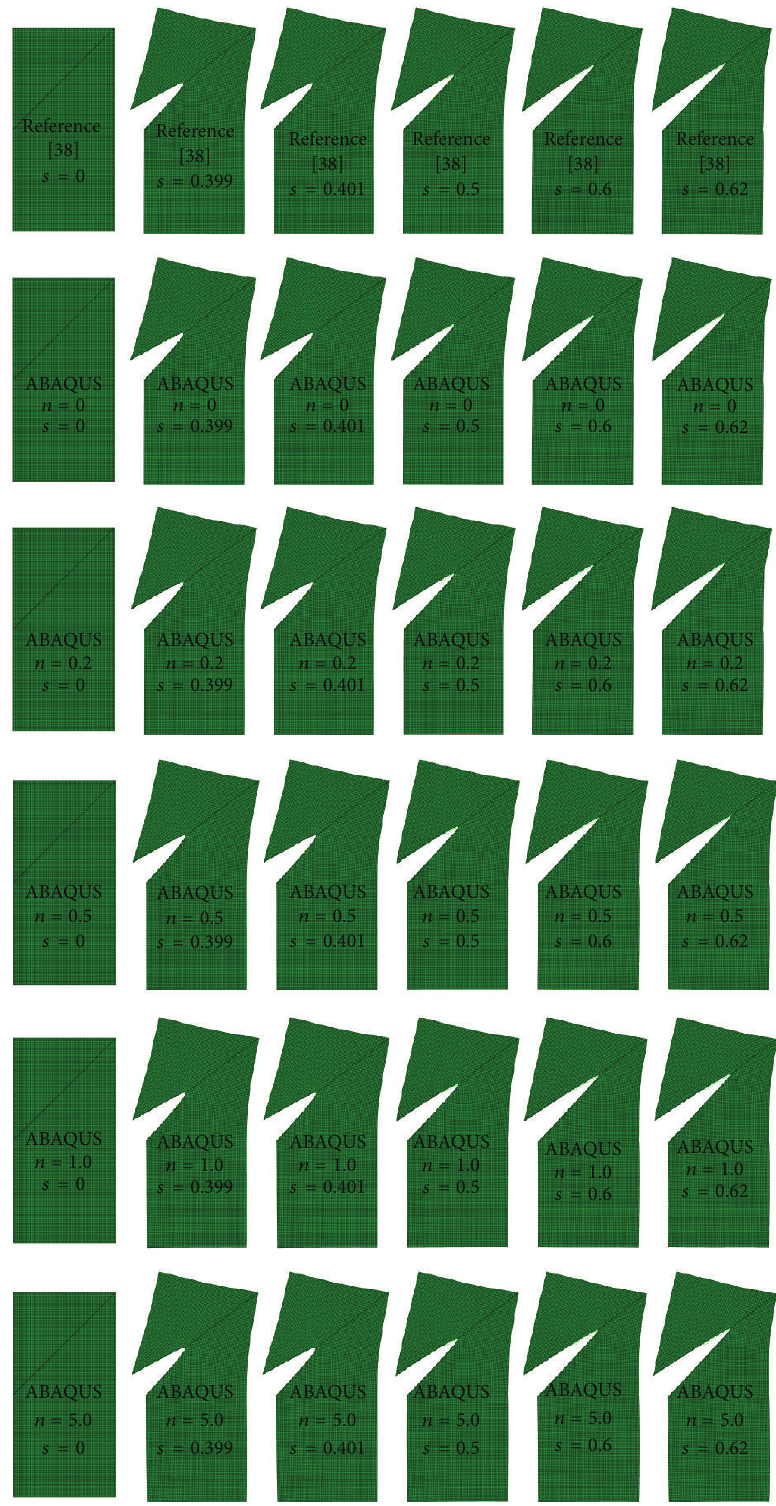
Figure 17: Deformed body for dynamic crack propagation at different crack length ( 𝐶 = 0.2